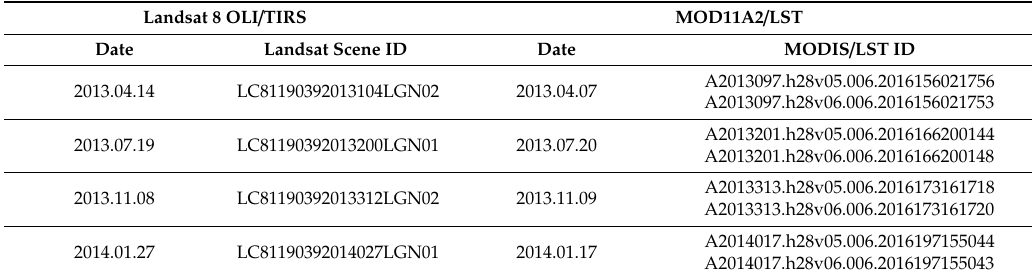
Table 1. The dates and remote sensing images IDs of data